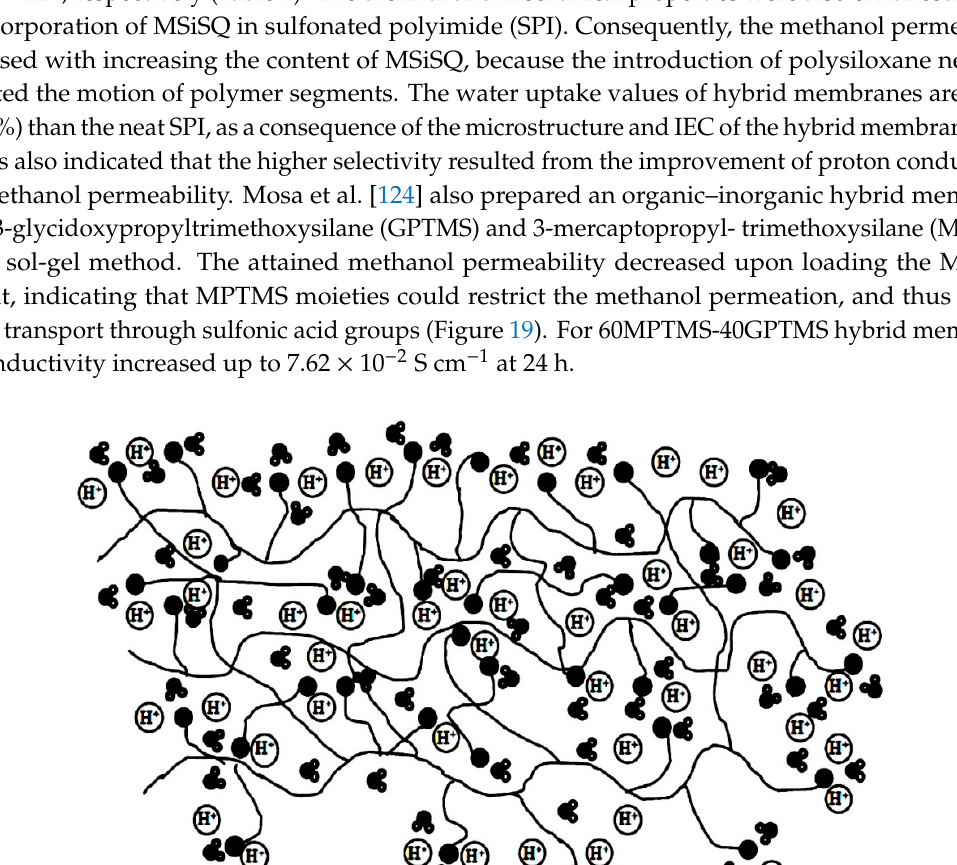
Figure 18. ( a ) Temperature-dependent proton conductivity of the membranes at 100% RH. ( b ) Methanol